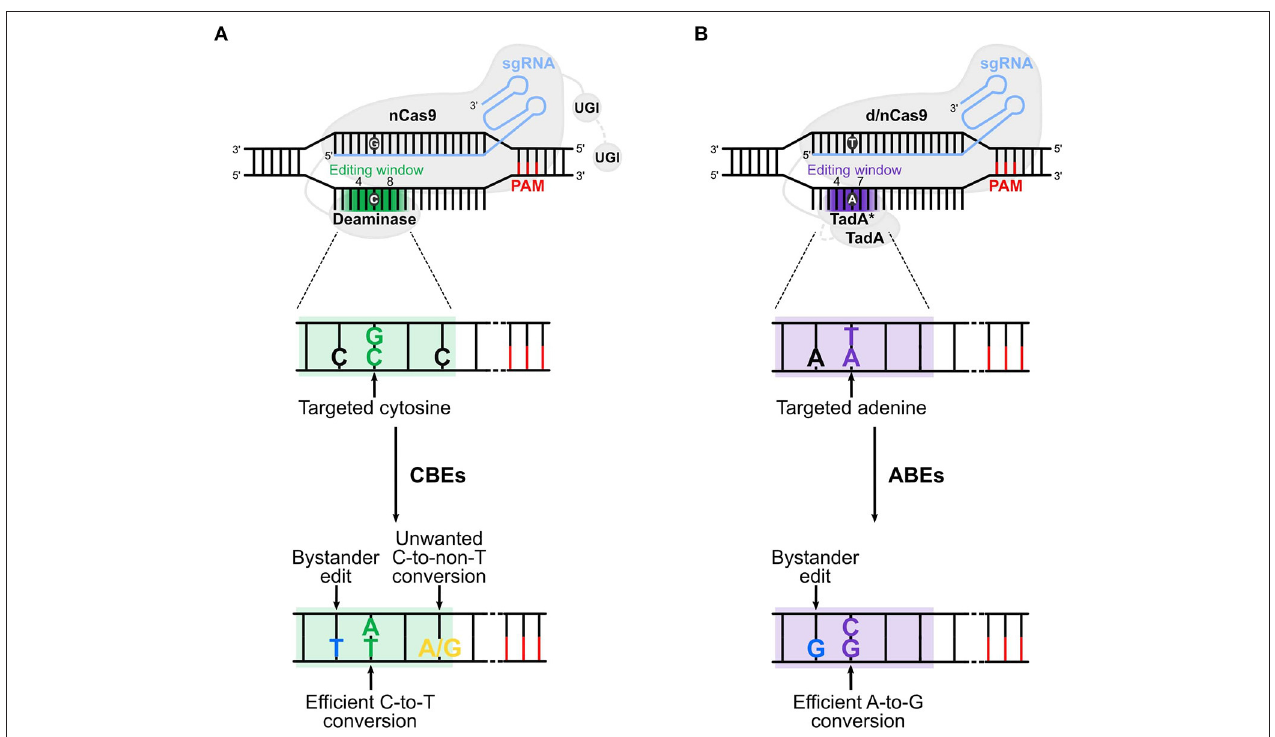
FIGURE 1 | Cytosine and adenine base editors. (A) Cytosine base editors (CBEs), composed of a nickase Cas9 (nCas9) fused to a deaminase and one (in BE3s) or two (in BE4s) UGI (uracil glycosylase inhibitor), convert C:G into T:A base pairs in the editing window (nucleotide 4 to 8 in the protospacer, in green). (B) Adenine base editors (ABEs) are composed of a dead (d) or nickase (n) Cas9 (d/nCas9) fused to two TadA, one evolved to edit adenine in DNA (TadA*) and one wild type (TadA). ABEs convert A:T into G:C base pairs in the editing window (nucleotide 4 to 7 in the protospacer, in purple). Cas9 is guided by the sgRNA to the protospacer [which